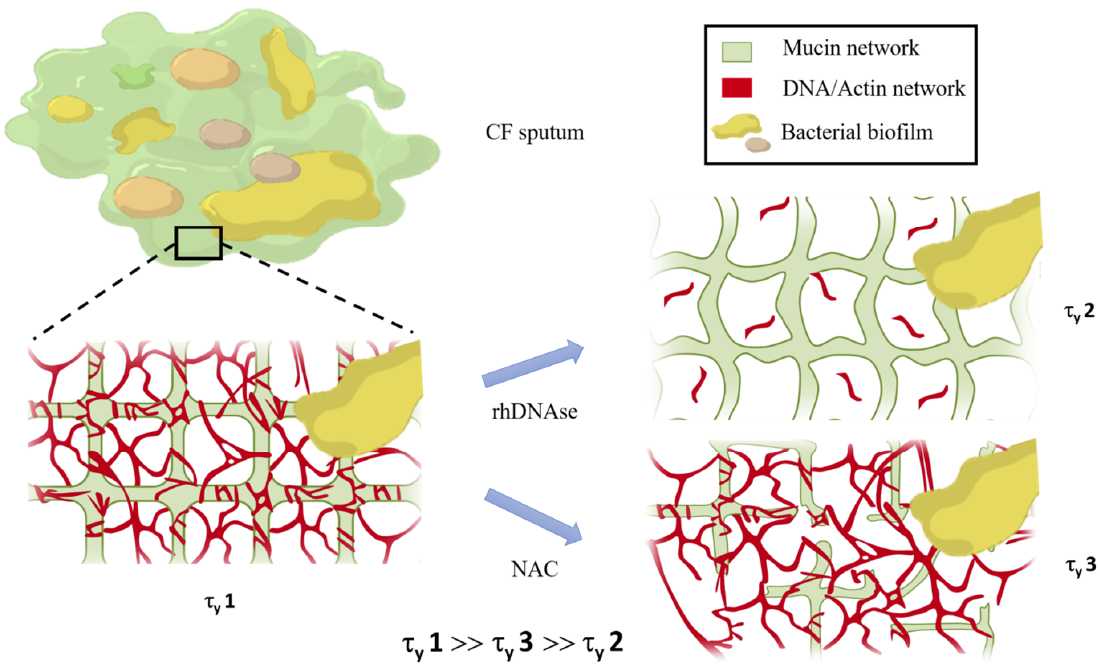
Figure 4. Schematic representation of CF sputum composed of two distinct networks and bacterial biofilm. Mucin and DNA/actin networks are interconnected. Untreated CF sputum exhibits high yield stress (τ γ 1). When CF sputum is treated with rhDNAse, the mucin network is preserved but DNA/actin network is broken, leading to the decrease in the apparent yield stress to the same level as that of non-CF sputum (τ γ 2). On the other hand, when CF sputum is exposed to NAC (N-acetyl-cysteine), some of the disulfide bridges of the mucin network are broken, but the DNA/actin network is largely preserved, resulting in a slightly lower decrease in the yield stress (τ γ 3).